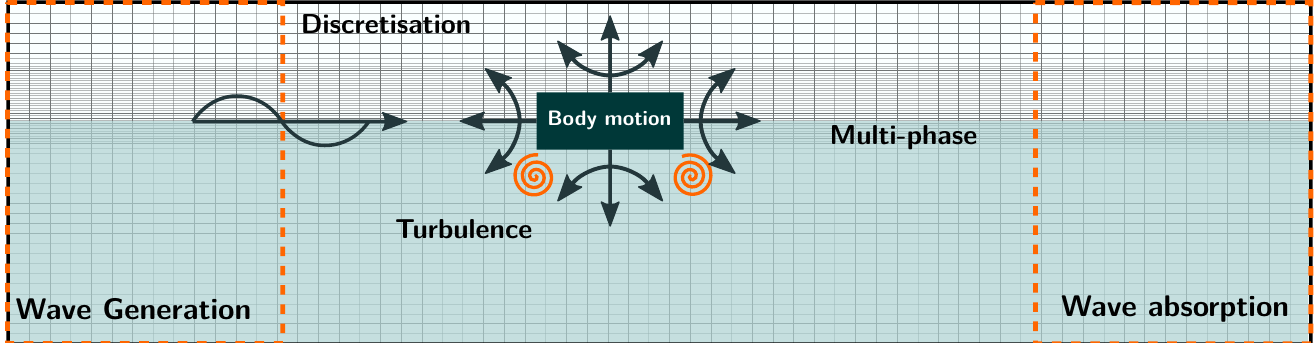
Figure 1. Visualization of the requirements for a CFD-based NWT for WEC analysis. (adapted from